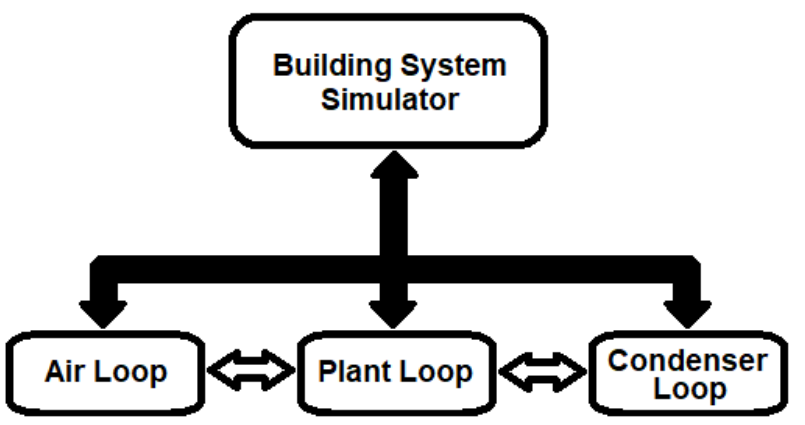
Figure 5. EnergyPlus ™ Simulate Building System .